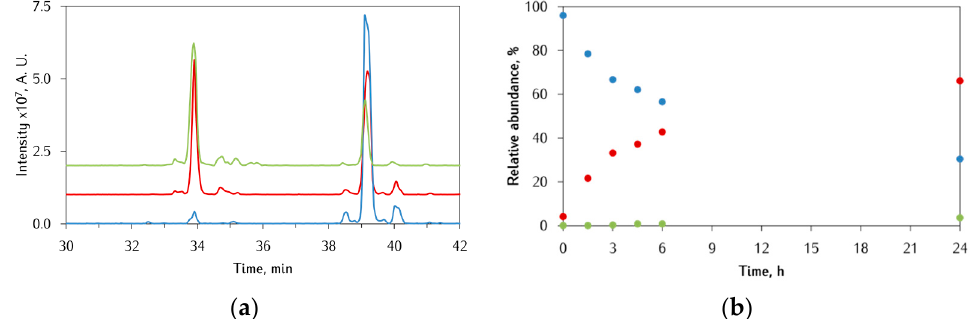
Figure 9. ( a ) HPLC-MS elution pro fi les of Ac- α S 119–132 (20 µM) in Mops bu ff er pH 7.0 at 37 °C, upon reaction with Fe II (10 µM) and DA (20 µM) at the beginning (blue), and after 6 h (red) and 24 h of incubation (green). ( b ) Per cent modi fi cation detected by the HPLC-MS analysis: Ac- α S 119–132 (t r 39 min, blue), Ac- α S 119–132 +16 (t r 33.8 min, red), Ac- α S 119–132 +32 (t r 35.2 min, green).